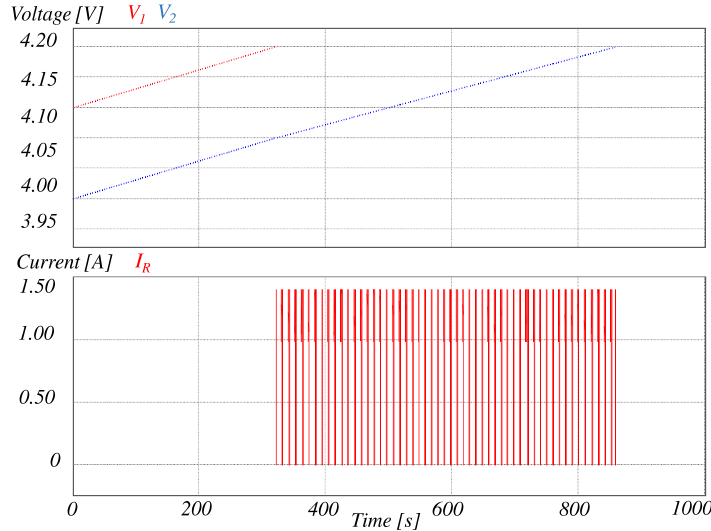
Figure 13. Resistor-based mode of operation with constant-current charge method ( I ch = 1.25 A).